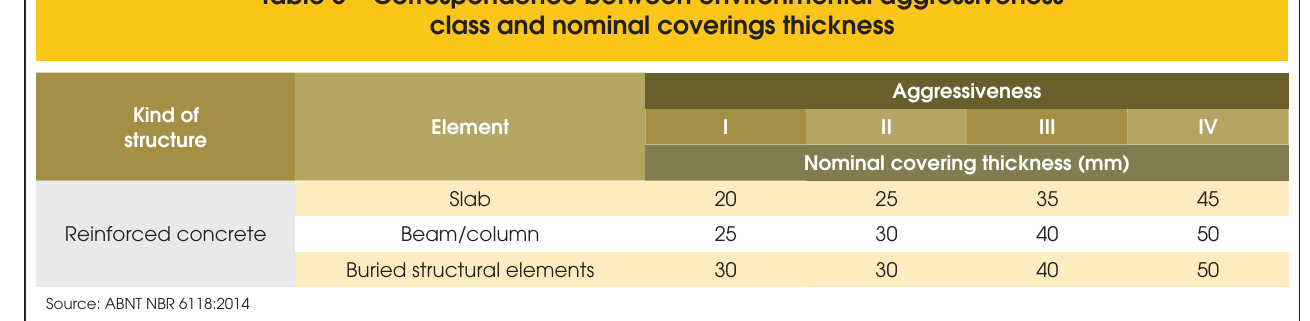
Table 3 – Correspondence between environmental aggressiveness